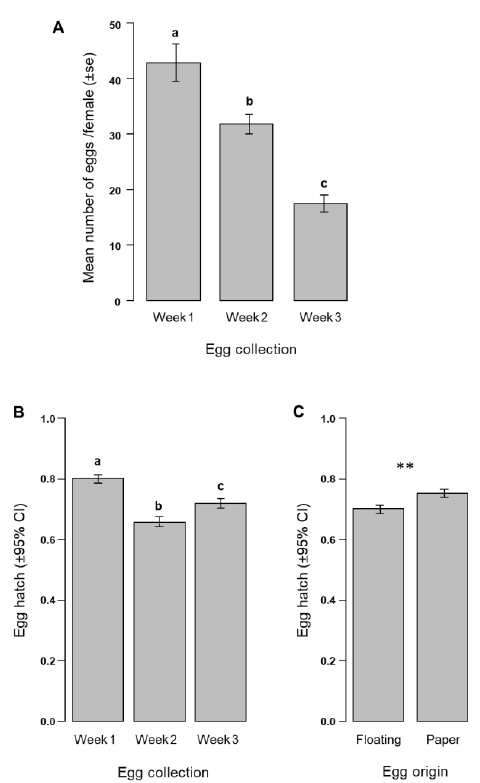
Figure 3. Aedes albopictus egg production and egg hatch. ( A ) Mean number of eggs per female according to the week of egg collection. Egg hatch according to the ( B ) week of egg collection and ( C ) egg